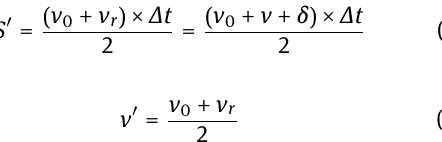
Where, ν 0 is the speed of the train at a moment. Because the system detects the idling/skidding phe- nomenon of the train, the measured speed value ν w of the wheel and axle speed sensor cannot represent the running speed of the train, so S is not the actual traveling distance of the train. The actual travel distance of the train should be revised to S (cid:48) and the speed to V